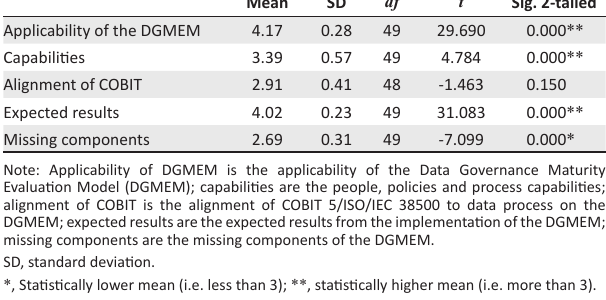
TABLE 9: One-sample t tests for the mean responses of theoretical variables. Overall variable